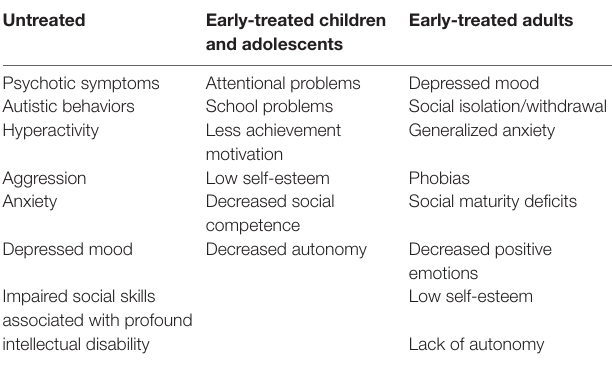
TABLE 1 | Neuropsychiatric symptoms as a function of treatment